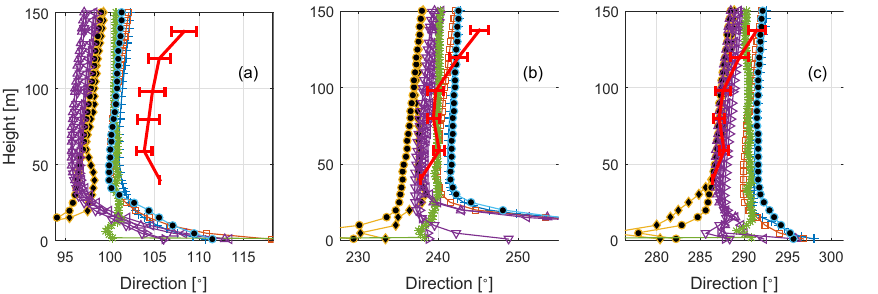
Figure 5. Wind direction profiles. The red full line shows the average from the sonics. Error bars indicate the 95% confidence level for the difference between the wind direction at each height and direction at 40m. The various other markers indicate simulated wind directions. Please see Table 1 for the legend of marker representations. LES models have been given black filling in order to increase readability. (a) Results from 100 ◦ , (b) from 240 ◦ , and (c) from 290 ◦ .